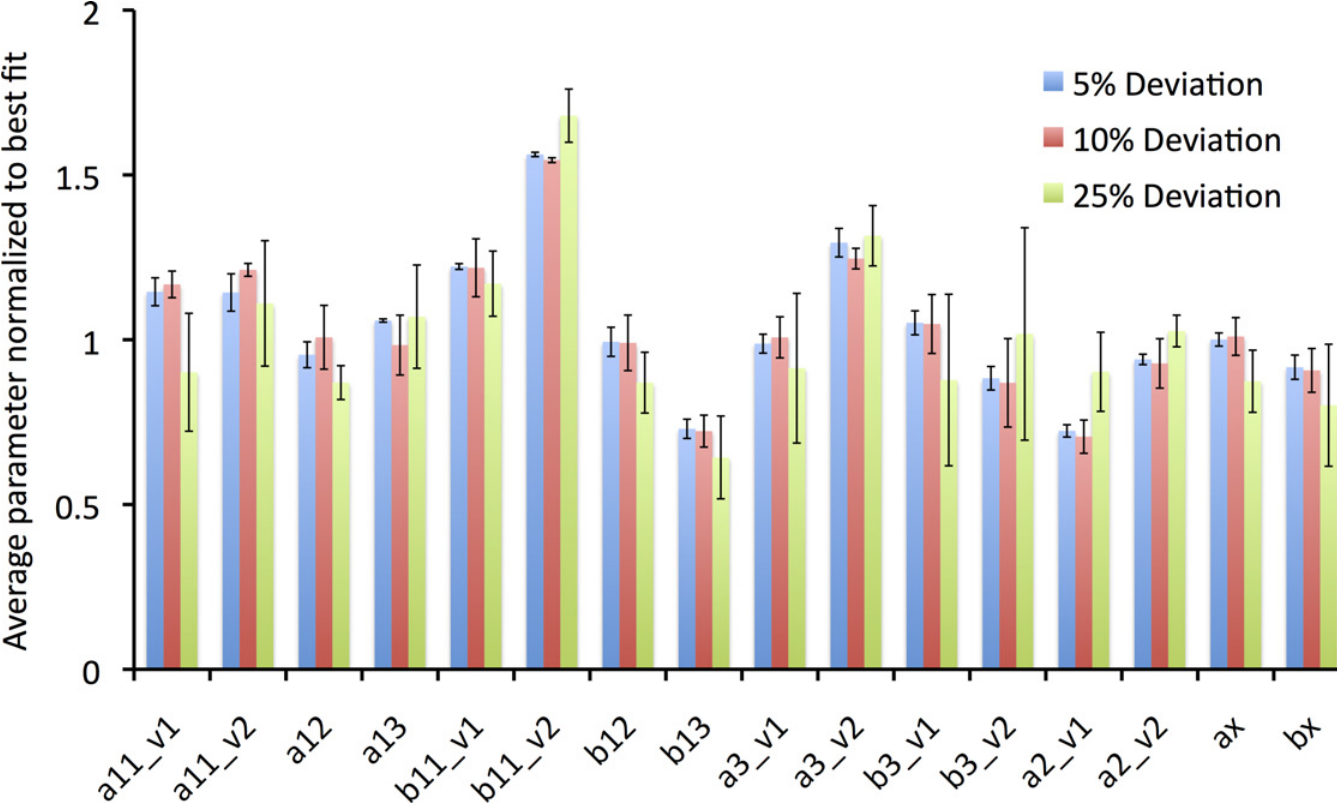
Fig 5. Robustness Analysis of Optimized Parameters. An optimization routine was set up such that a “ true ” global minimum was defined as the optimized parameters. The previously found optimized values were perturbed by a random number with a 5% (n = 3 runs), 10% (n = 3 runs), or 25% (n = 3 runs) deviation. The deviated parameters were used as the initial guesses, and the optimization algorithm was restarted. The graph shows the averaged parameter values from each set of runs, normalized to the optimized starting value. A value of 1 with no error bar would mean that the strategy found the exact optimized value. The error bars show ± 1 standard deviation, normalized to the average value found from the runs. As can be seen, the algorithm performed best with smaller deviations from the optimum value, and many parameters were sufficiently constrained, even with large (25%)